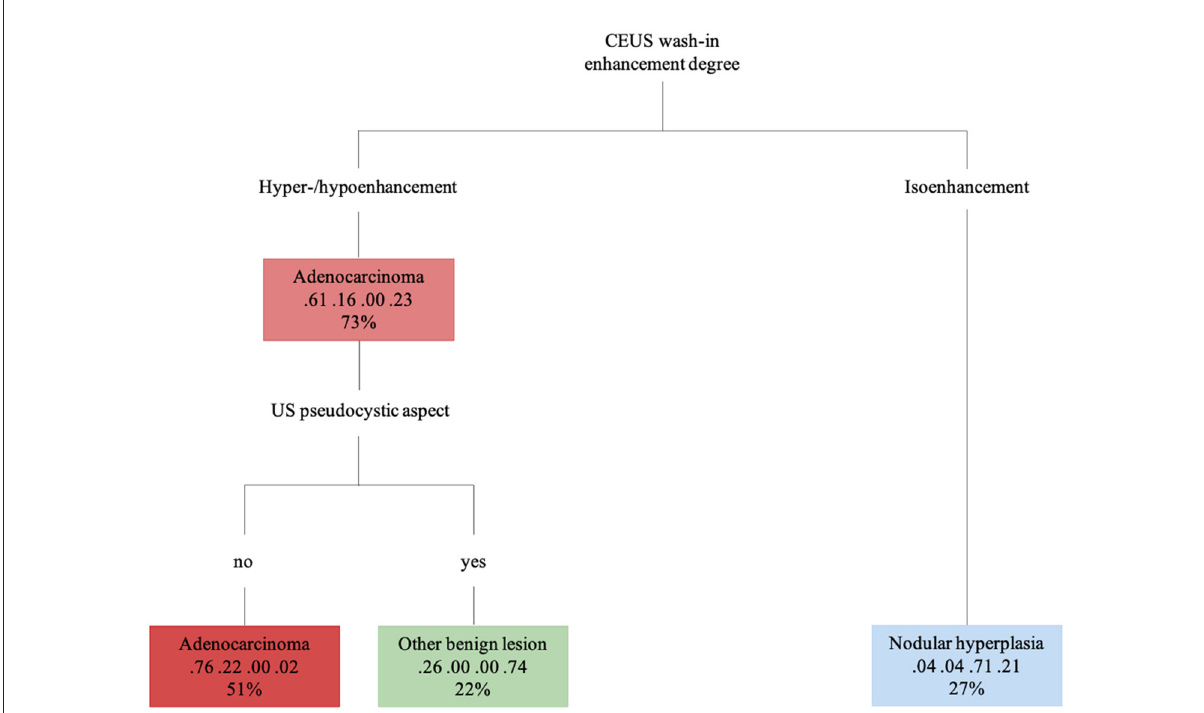
FIGURE9 The machine learning-based decision tree developed on the qualitative and the quantitative CEUS features of the focal pancreatic lesions. The probability of each class at a specific node and the percentage of observations used at that node are reported as the second and third lines in each box, respectively.